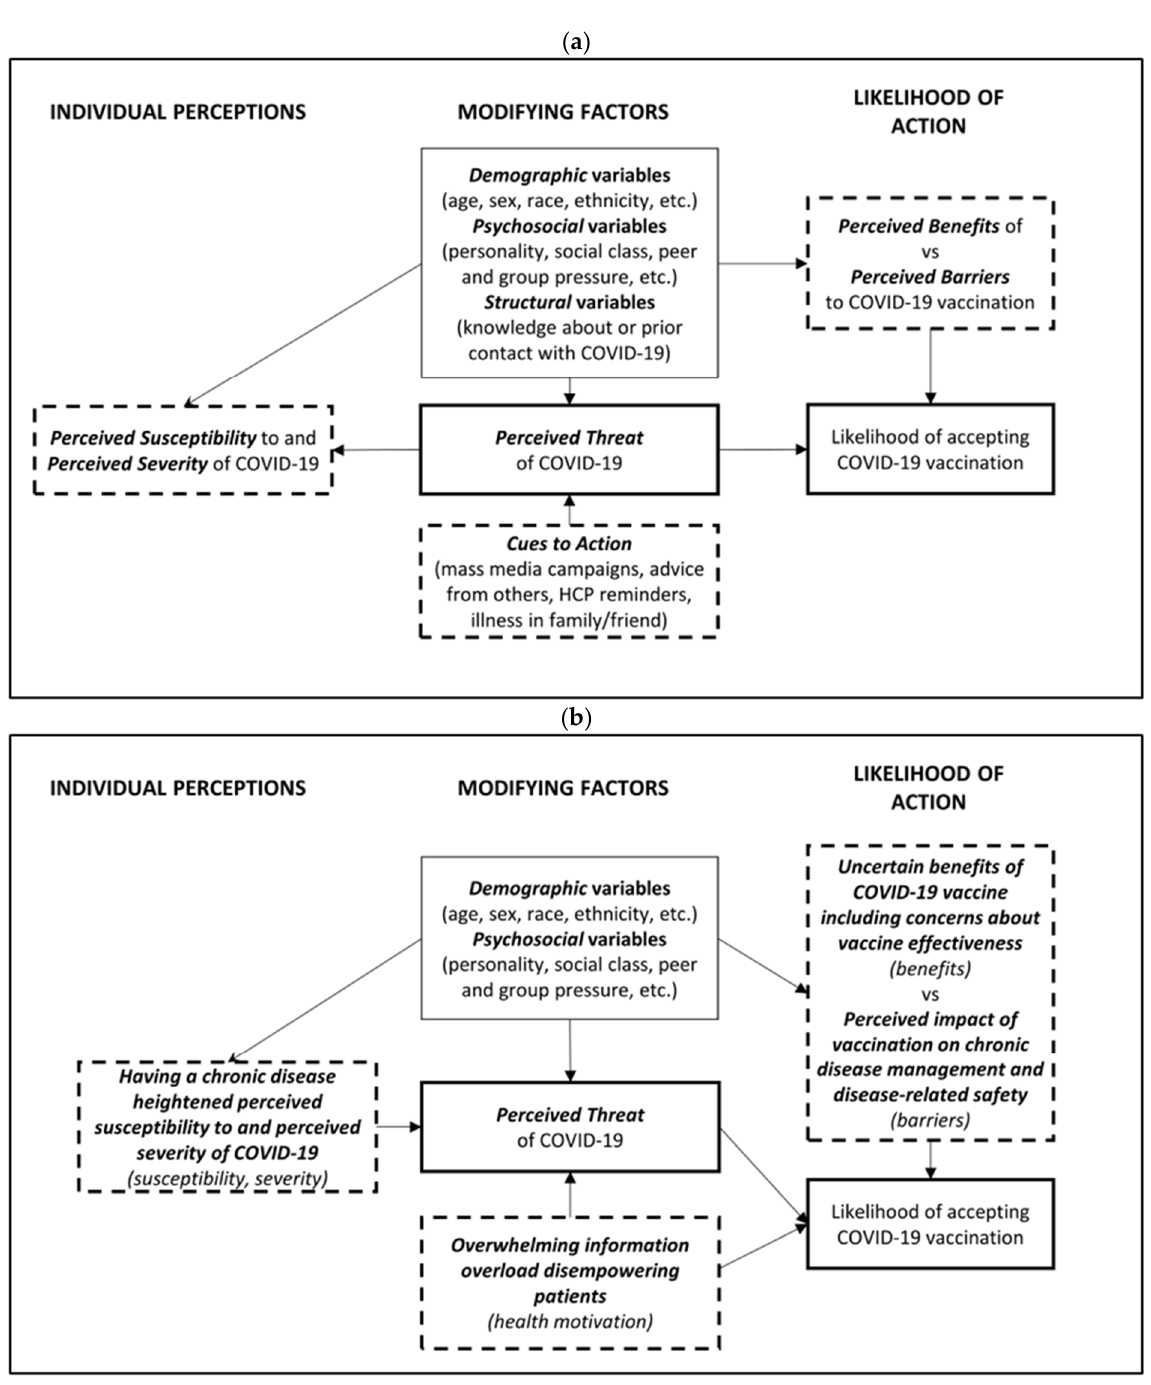
Figure 2. The Health Belief Model [21]; ( a ) adapted for the likelihood of COVID-19 vaccination and ( b ) adapted for the likelihood of COVID-19 vaccination with the four key themes from the qualitative analysis of free ‐ text comments.